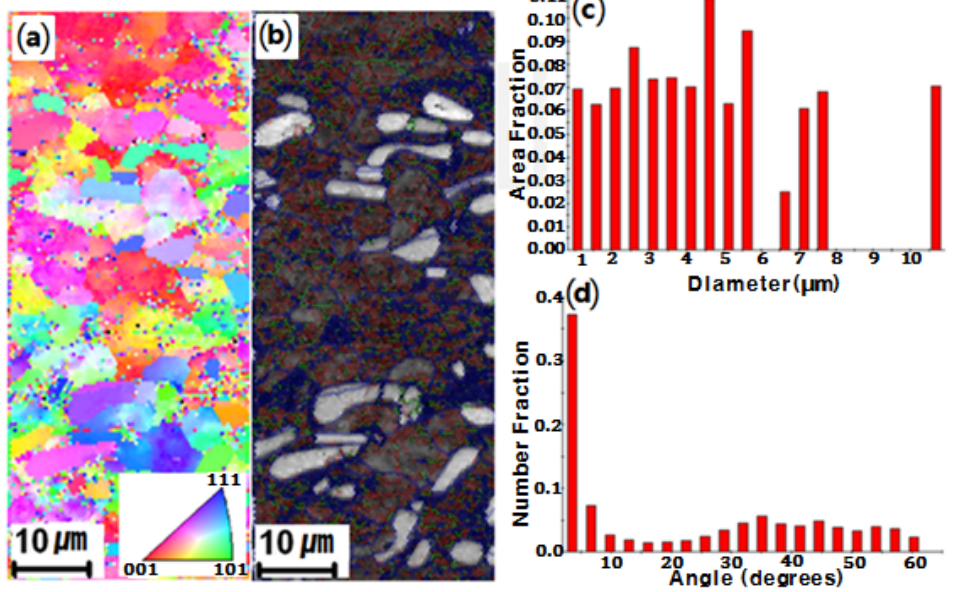
Figure 2. EBSD analysis data of the as-received alloy: ( a ) EBSD map (the insert in bottom right corner of ( a ) showing the representation of the color key used to identify the crystallographic orientations on a standard stereographic projection); ( b ) grain boundary misorientation map; ( c ) grain size distribution; ( d ) misorientation angle distribution.